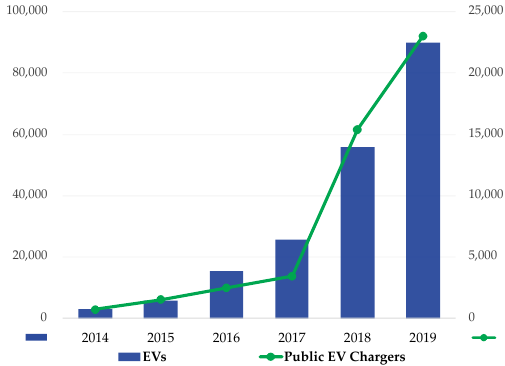
Figure 1. Growth of the electric vehicle (EV) market in